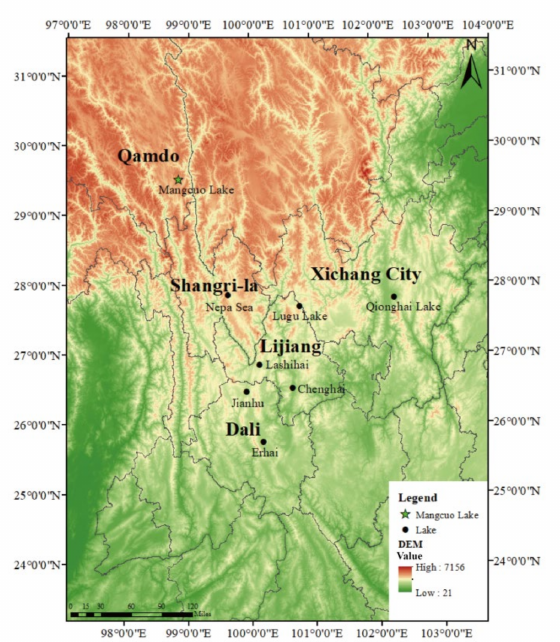
Table 4. Relative position of Mangcuo Lake to the lake group.